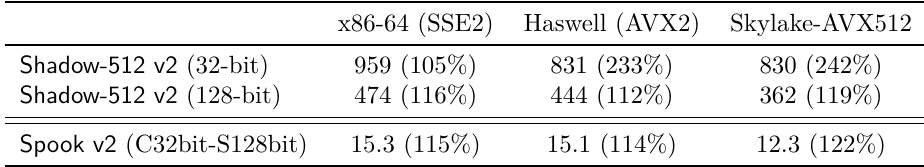
Table 15: High-end software performance results. Number of cycles compiled for various micro-architectures, and throughput (cycles per byte) for a message of 2048 bytes. The percentages are the comparison with the Spook v1 corresponding metrics. The Shadow-512 v2 32-bit implementatuib exhibits large cost increase on some platoforms due to the inability of the compiler to perform some (vectorization) optimizations.